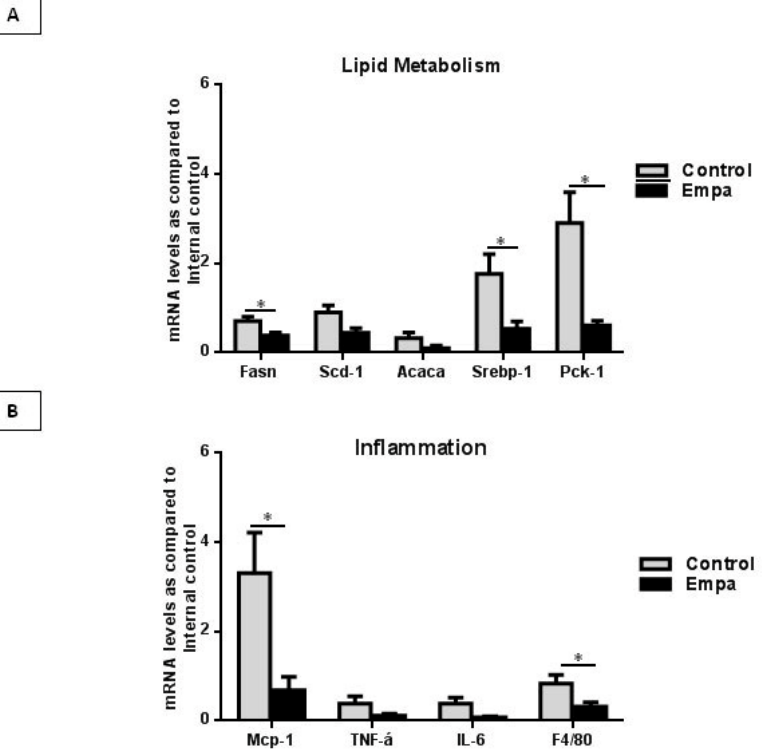
Figure 3. The hepatic expression of lipogenic enzymes and inflammatory markers in ApoE (-/-) mice after five weeks of empagliflozin/vehicle oral administration. ( A ). The mRNA levels of Fasn , Screbp-1 and Pck-1 were significantly reduced in the Empa group as compared to the Control group. ( B ) Empagliflozin oral administration for five weeks resulted in significant reduction in Mcp-1 and F4/80 mRNA levels. Data are shown as the mean ± SEM (*: p < 0.05).